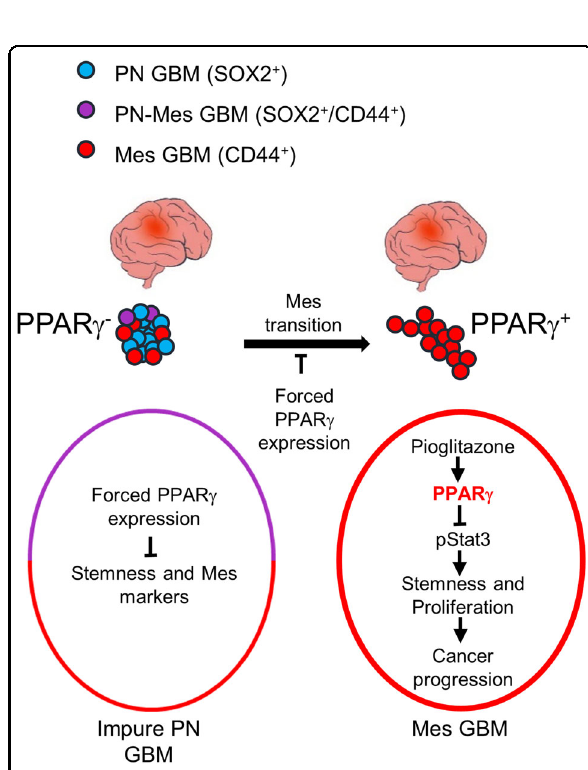
Fig. 6 Hypothetical model of PPAR γ as a therapeutic target in GBM. Among two mutually exclusive subtypes of GBM, PPAR γ is speci fi cally expressed in mesenchymal type. In proneural GBM, the overexpression of PPAR γ reduced stemness and mesenchymal markers. The recovery of PPAR γ in proneural type during proneural- mesenchymal transition attenuated this process. In mesenchymal GBM, the activation of endogeous PPAR γ by ligands inhibited GBM